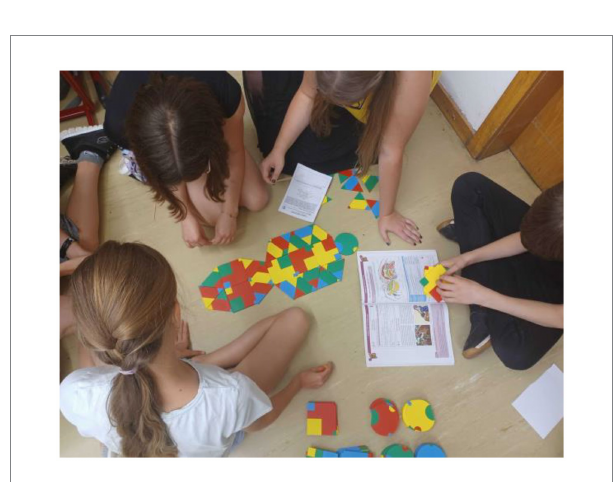
FIGURE 4 Students solving biology tasks with PolyUni files in